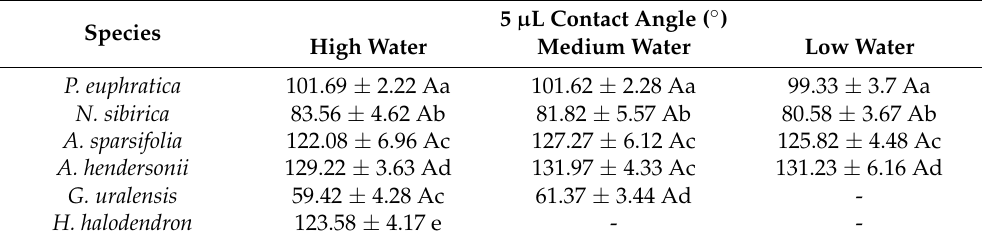
Table 2. Determination of contact angles of the leaves of six desert plant species.